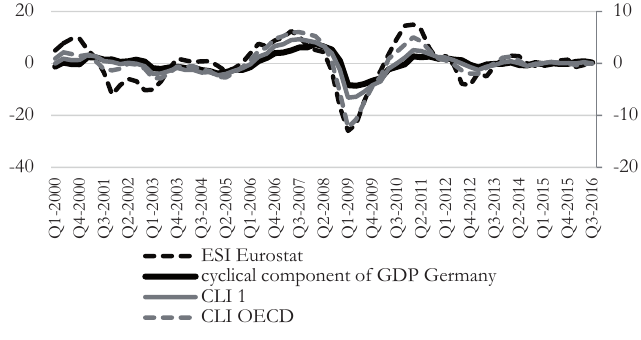
Fig. 3 – Graphical development of indicators produced by different organizations and their comparison with GDP development. Source: own processing